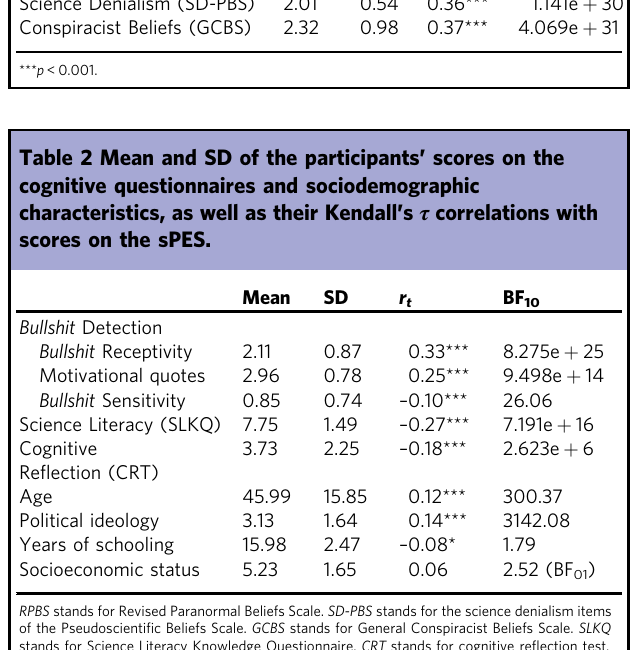
Table 3 Summary of the regression models for each type of epistemically unwarranted belief.